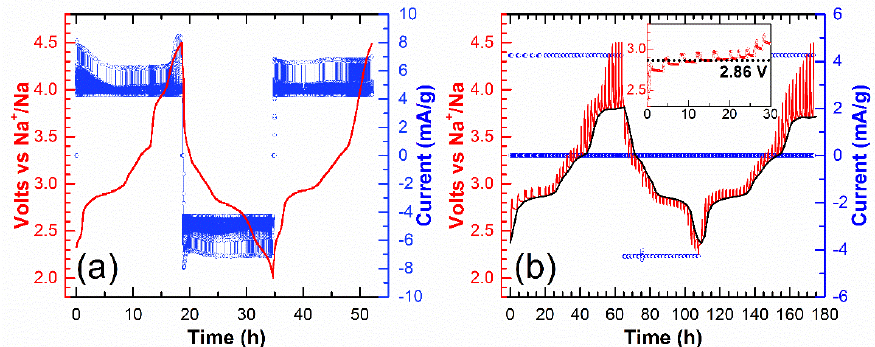
Figure 3. ( a ) PITT curve for one and a half cycles in the potential range 4.5 – 2.0 V using 10 mV potential